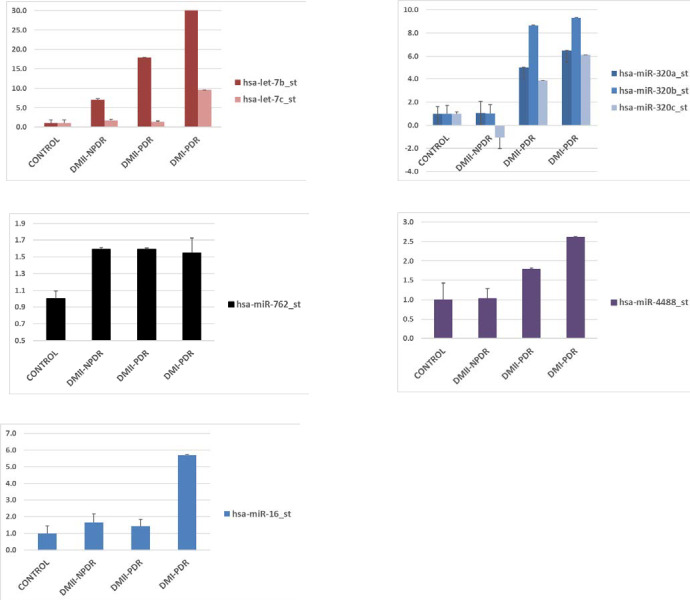
Select set of differentially expressed miRNA in vitreous in DRI-PDR, DRII-PDR and DRII-NPDR.